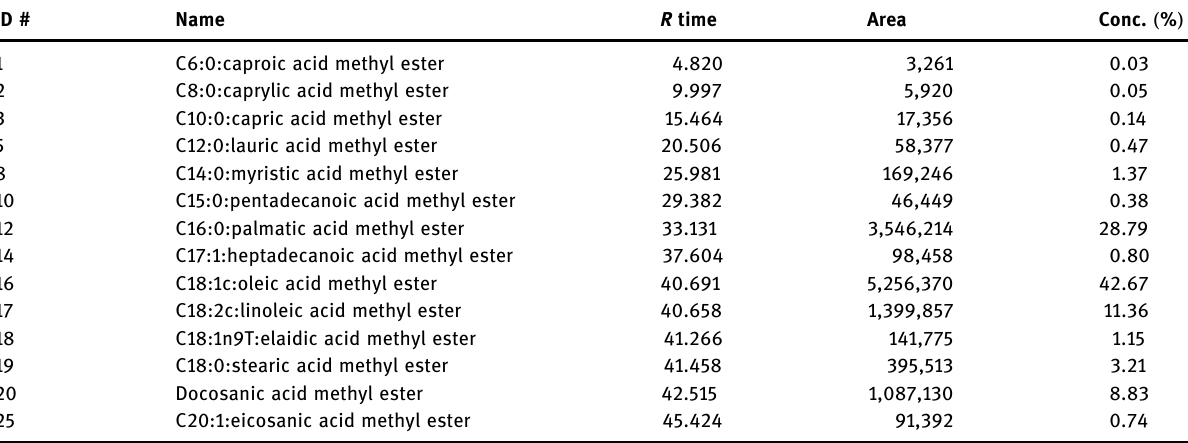
Table 2: Quantitative results of oil extracted from HO fraction of F. benghalensis ID